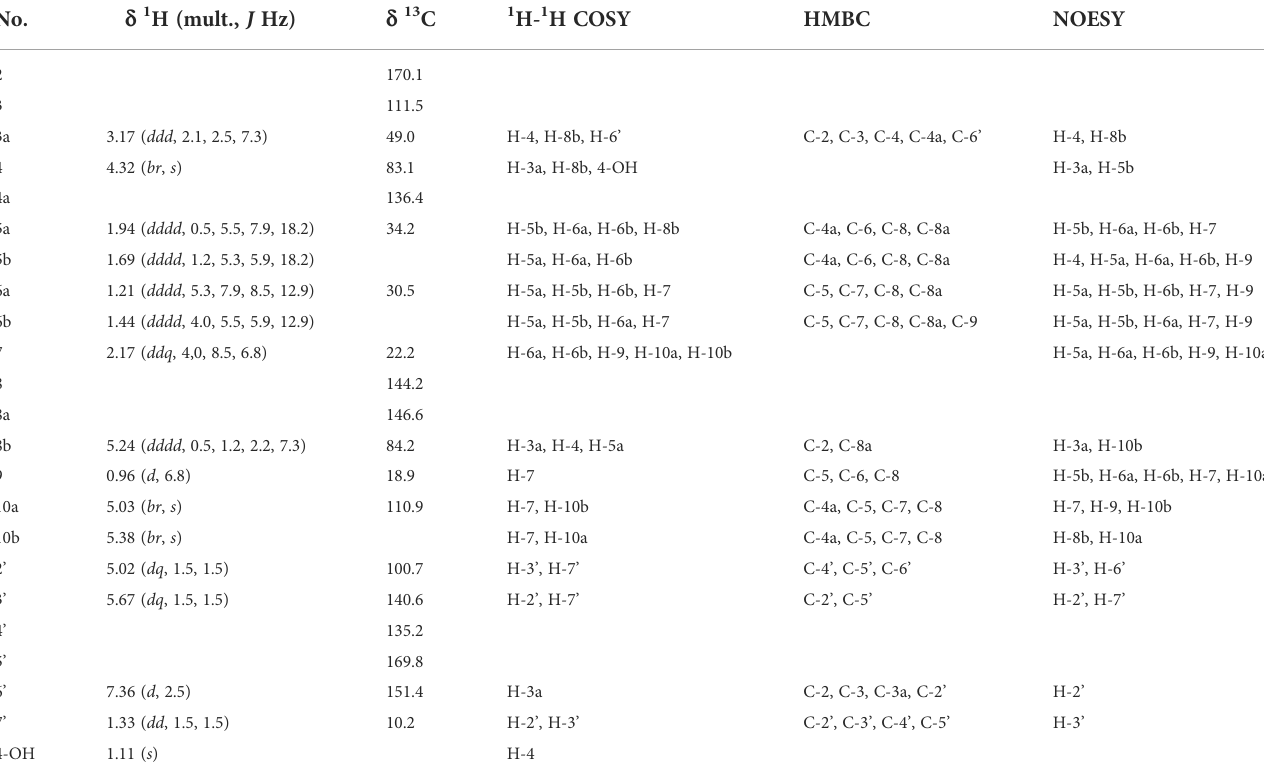
TABLE 2 NMR spectroscopic data of